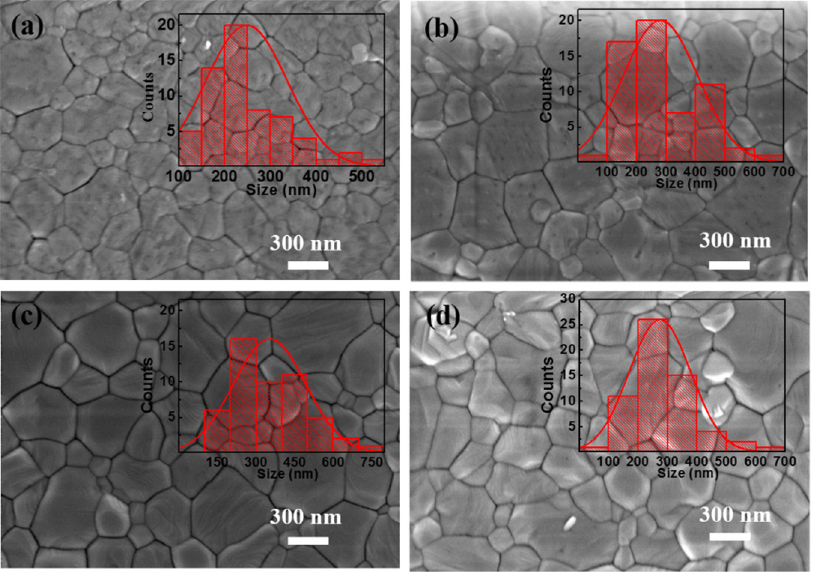
Figure 3. SEM images of the MAPbI3 films with different CsPbI3 concentrations: ( a ) 0, ( b ) 1 wt%, ( c ) ( c ) 2 wt%, ( d ) 3 2 wt%, ( d ) 3 wt%.